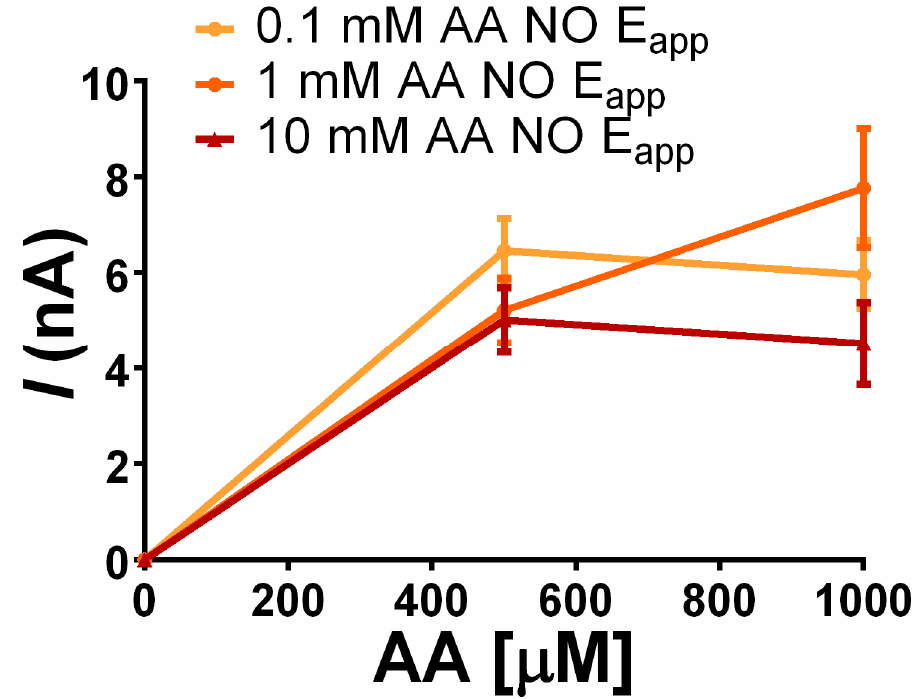
Figure 5. Ascorbic acid (AA) calibrations of sensors treated with Chemiplus 2DS HB (n = 4 for each experimental group) after 5 days of storage under different AA concentrations and without potential applied: treated electrodes stored in a 0.1 mM solution of ascorbic acid (0.1 mM AA NO E app ), treated electrodes stored in a 1 mM solution of ascorbic acid (1 mM AA NO E app ), and treated electrodes stored in 10 mM solution of ascorbic acid (10 mM AA NO E app ).